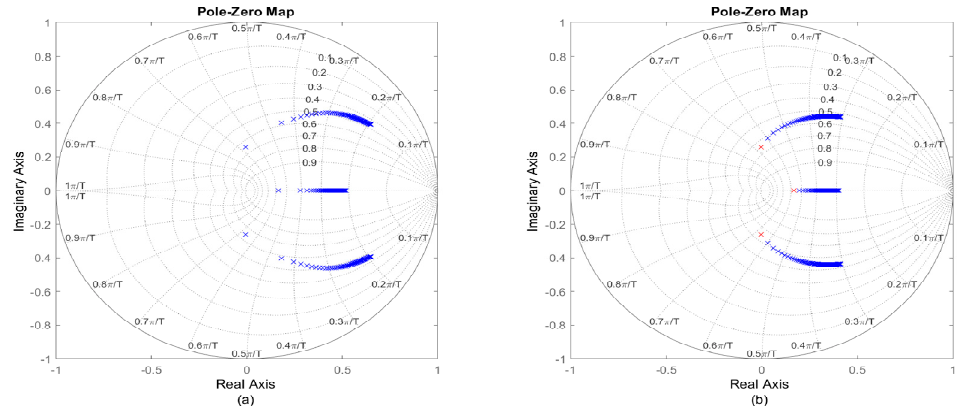
Figure 4. CCS – MPC closed − loop poles for 𝑟 𝒘 variation from 0 – 10. ( a ) 𝑁 (cid:3043) = 5, 𝑁 (cid:3030) = 3. ( b ) 𝑁 (cid:3043) = Figure 4. CCS–MPC closed − loop poles for r w variation from 0–10. ( a ) N p = 5, N c = 3. ( b ) N p = 150, 150, and 𝑁 (cid:3030) = 50. and N c =